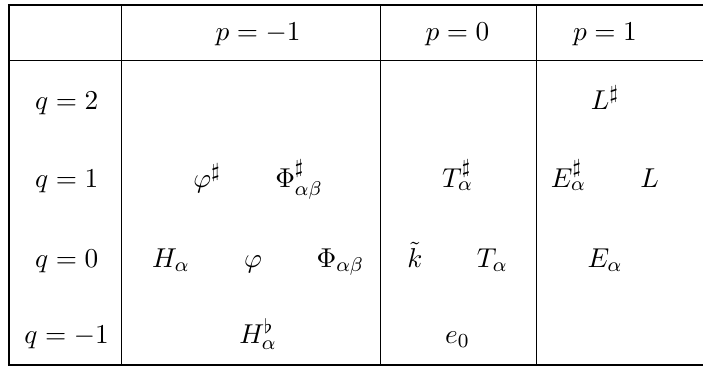
Table 5 . Basis elements of W when g + is the a(cid:14)ne extension of g .